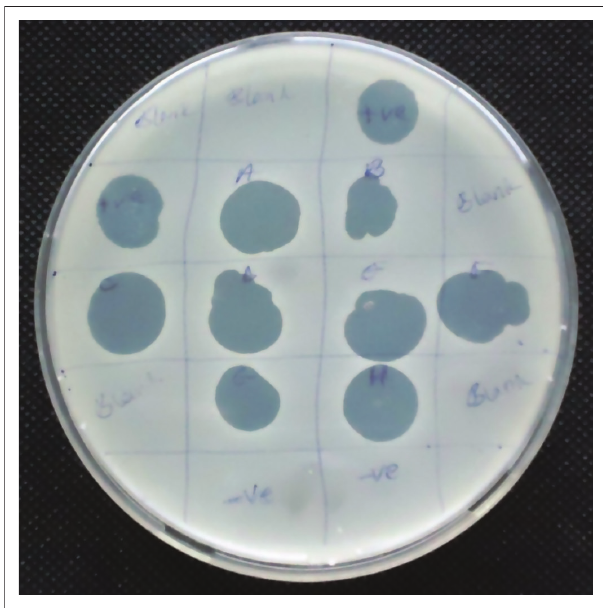
FIGURE 3: Spot assay showing most virulent phage